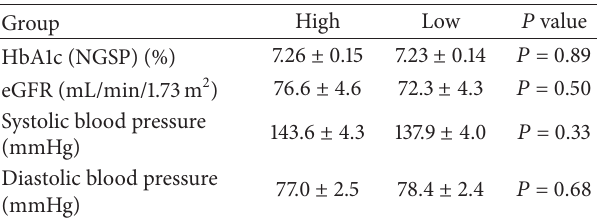
Table 4: Laboratory data at the entry partitioned by the cutoff value of UAGTCR before treatments.